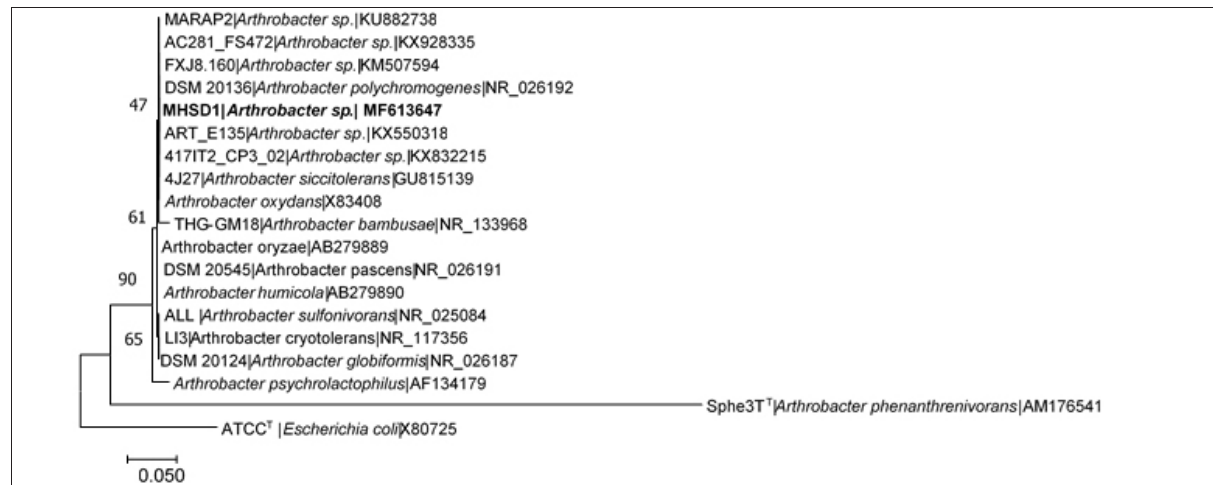
Figure 1: Maximum likelihood tree based on the 16S rRNA gene sequences of Arthrobacter sp . MHSD1 and its closest phylogenetic neighbours. The numbers on nodes indicate bootstrap values after 1000 replicates expressed in percentages. Escherichia coli strain ATCC X80725 was included as an outgroup. T indicates type strains.